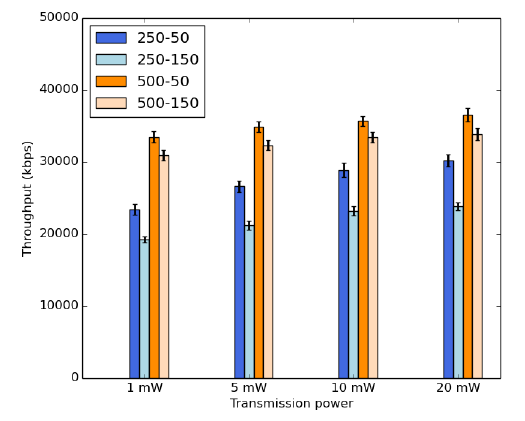
Figure 16. Average throughput.